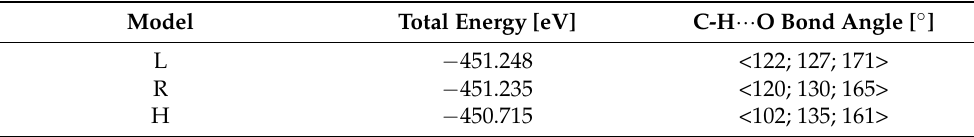
Figure 2. Graph of total energies’ differences of all 64 models of TMAH, in [eV], L-model with the lowest total energy, H-model with the highest total energy, R-randomly chosen model with a total energy higher than for the L model and lower than for the H model. Table 3. Total energies and C-H ··· O bond angle ranges for TMA-H models. The ranges are given as <minimum; median;